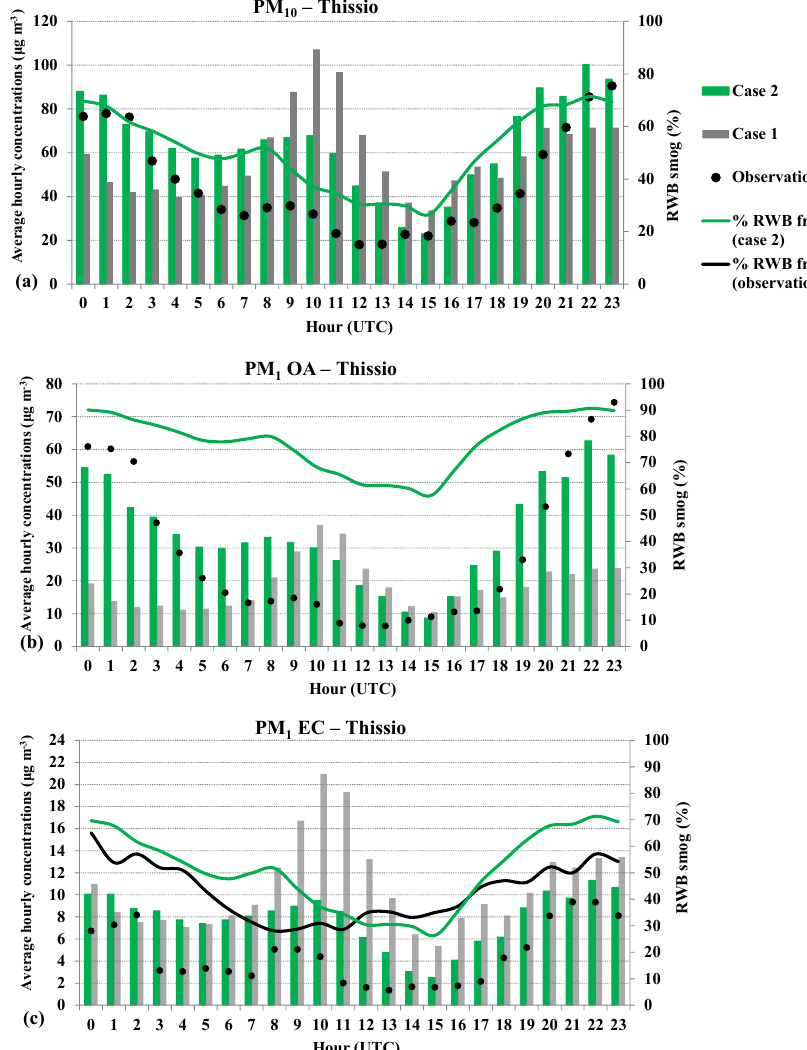
Figure 5. The mean daily cycle of mass concentrations (µgm − 3 ) from measurements (black dots) and from model outputs (case 1 in grey columns and case 2 in green columns) and of RWB fractions (%) from measurements (black line; only BC wb fraction is measured) and from model outputs (case 2 in green line) for (a) PM 10 , (b) PM 1 OA and (c) PM 1 BC. All values refer to the Thissio site (Athens), and they correspond to the intense smog wintertime